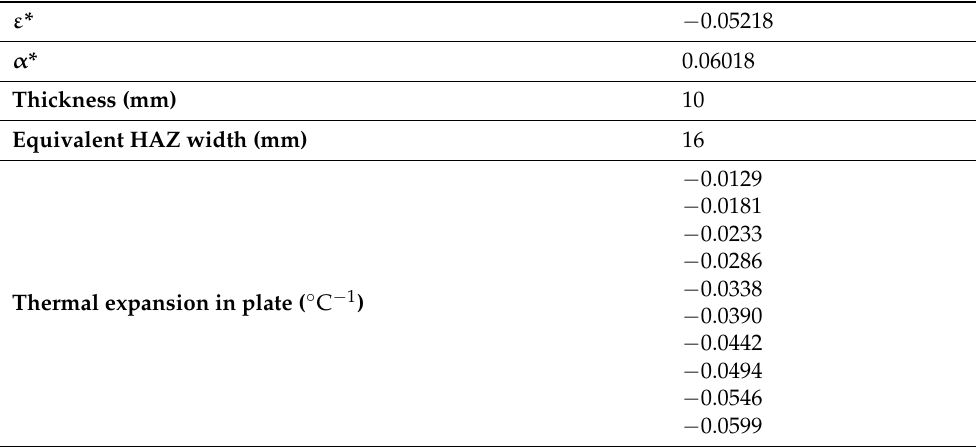
Table 6. Converted input variables for final distortion prediction.